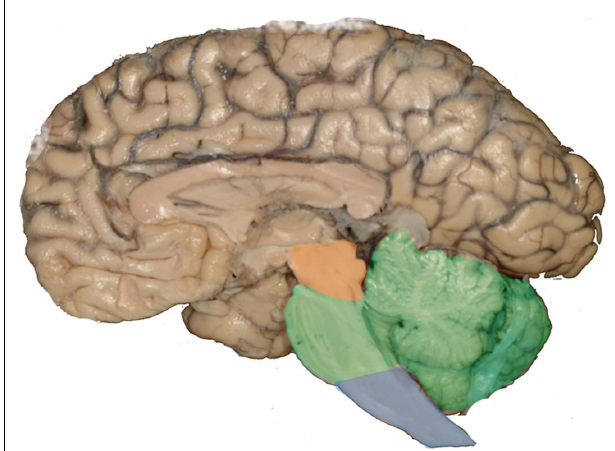
FIGURE 1 | Human brainstem. Sagittal view.The brainstem is divided rostrocaudally into midbrain (orange), metencephalon (green), and medulla oblongata